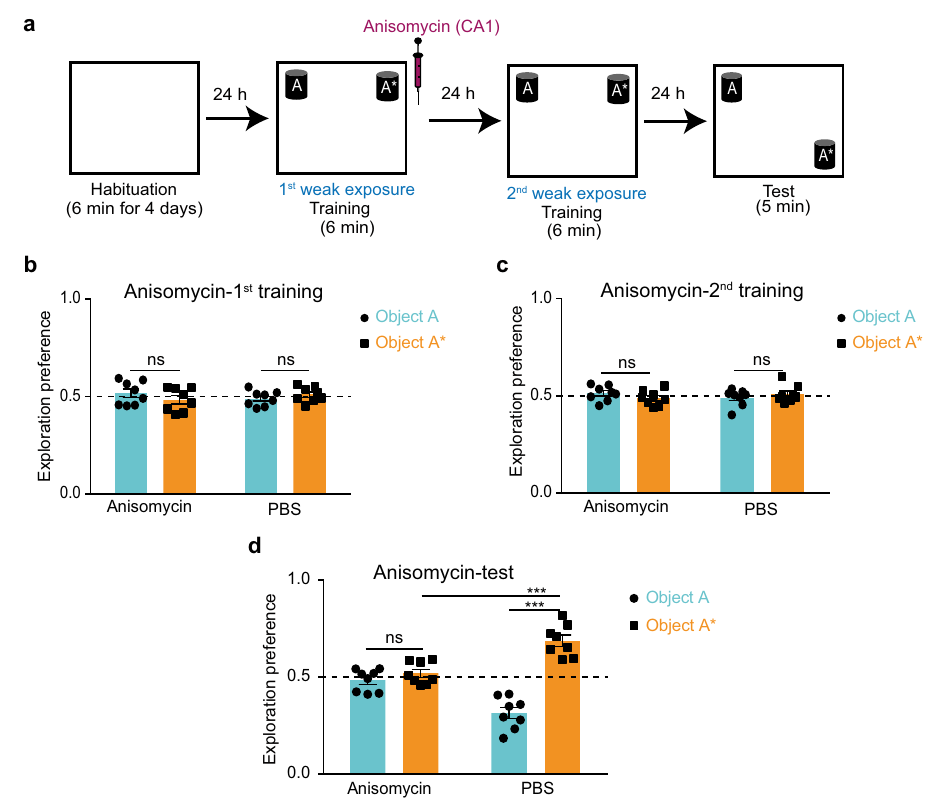
Fig. 4 Long-term storage of STM trace is protein-synthesis dependent. a NOL two-training paradigm with 1-day interval in between with anisomycin injection after the fi rst training session into the CA1 region. Exploration preference for each object during the fi rst ( b ) and the second ( c ) training sessions for anisomycin- ( n = 8) and PBS- ( n = 8) injected groups. d Exploration preference for each object during the test session for anisomycin- ( n = 8) and PBS- ( n = 8) injected groups. Comparisons were made using paired student ’ s t-test for comparing object A and object A* in the same group, and unpaired student ’ s t-test for comparing object A* within different groups; ns, not signi fi cant ( P > 0.05), *** P < 0.001. Data are presented as the mean ± SEM.